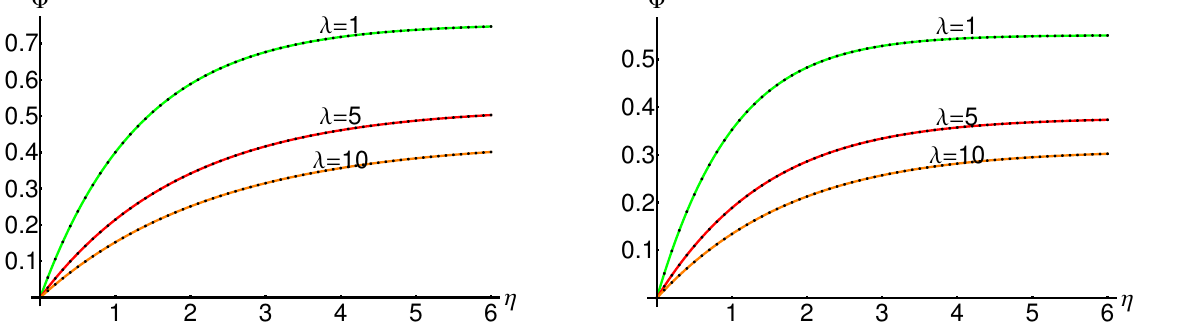
Figure 3: Variation of Φ by increasing the slip parameter λ for ax- isymmetric flow and impermeable sheet ( m = 2, α = 0) : — numerical solution; ...... OAFM solution